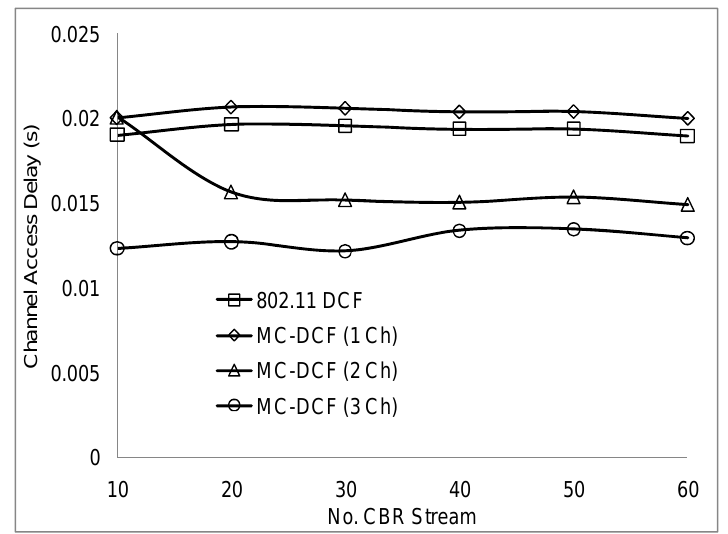
Figure 9. Delay impact on CBR